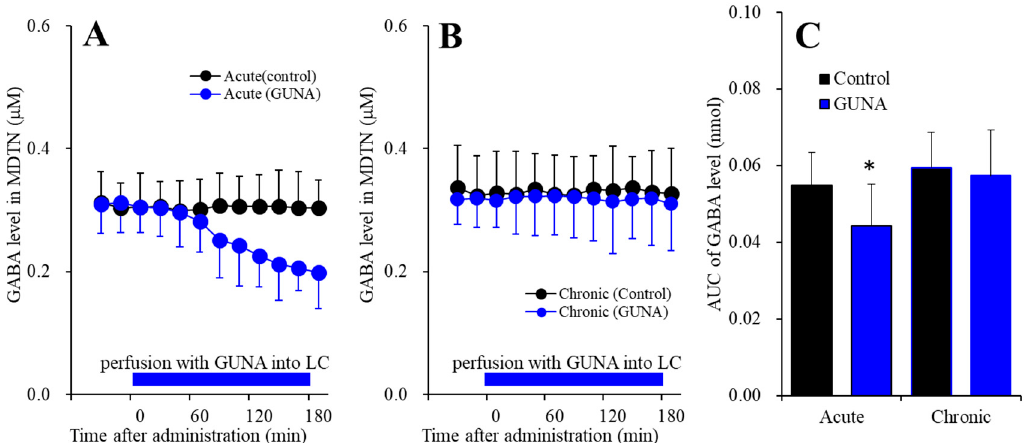
Figure 5. Effects of acutely local administration (perfusion with) 200 nM guanfacine into the LC on extracellular GABA level in the MDTN, after the systemically chronic administration of guanfacine (0 or 0.12 mg/kg/day for 14 days). Panel ( A ) indicates the effects of perfusion with 200 nM guanfacine into the LC after chronic administration of guanfacine (0 mg/kg/day) for 14 days (acute effects). Panel ( B ) indicates effects of 200 nM guanfacine after systemically chronic administration of guanfacine (0.12 mg/kg/day) for 14 days (chronic effects). Ordinates: mean±SD (n = 6) of extracellular GABA level ( μ M), abscissa: time after administration of perfusion with guanfacine into the LC (min). Blue bars: perfusion of 200 nM guanfacine into LC. Panel ( C ) indicates the AUC20–180 min values of extracellular GABA level during perfusion with guanfacine (from 20 to 180 min). Ordinates: mean ± SD (n = 6) of AUC20–180 min values of extracellular GABA level (pmol). Black and blue columns indicate respective control and perfusion of guanfacine of AUC values of GABA levels. When the effects of guanfacine were statistically significant compared using MANOVA, the data were analysed using Tukey’s post hoc test. * p < 0.05, compared with control.